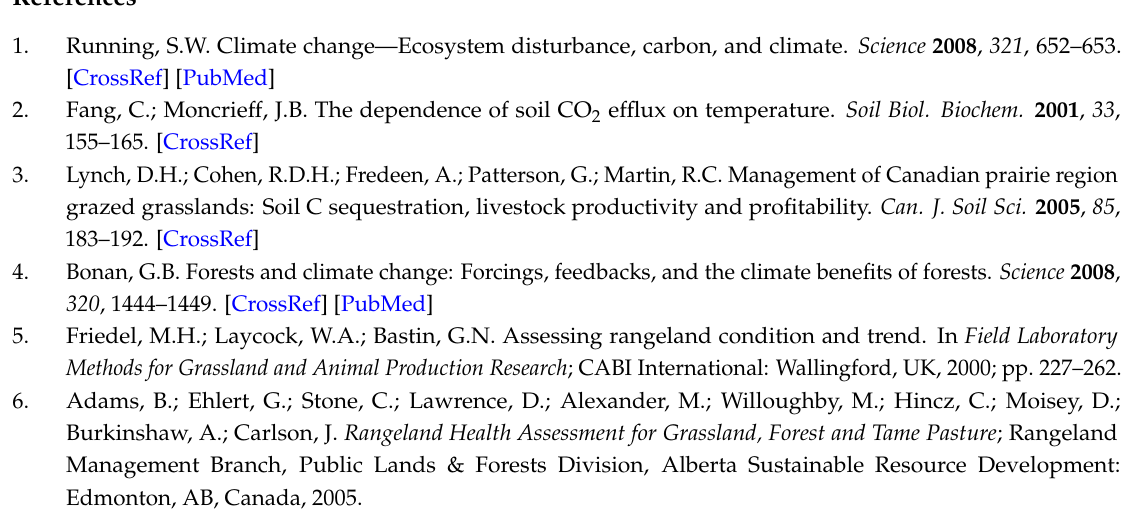
Table S1: R 2 and equations for fits between net CO 2 flux and different midday averaging period of proxy NDVI calculated both for the full season and for the first and second halves (green-up and senescence). The average intervals considered were 5-h, 3-h and 1-h around midday (approximately 13:30 local daylight savings time). In all cases, proxy NDVI was filtered with the method explained in the